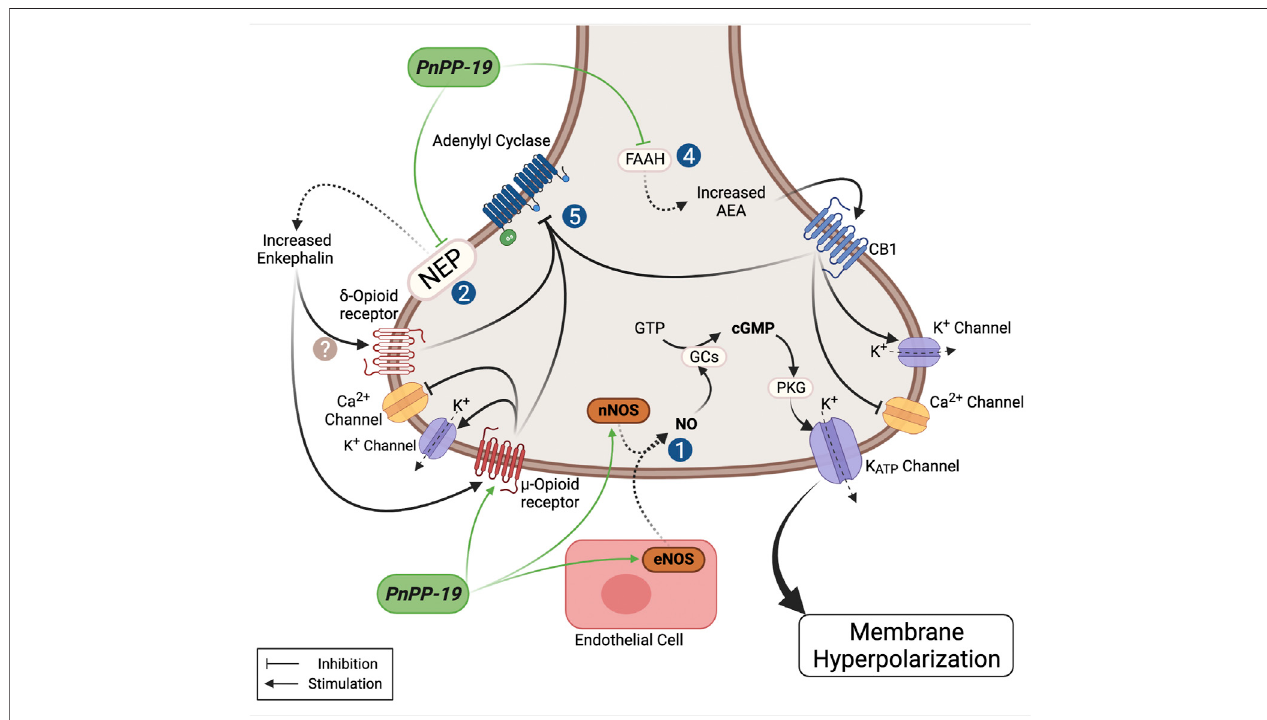
FIGURE3| SchematicmodelshowingthepossibleactionsofthePnPP-19peptide onantinociception. PnPP-19actsperipherallyandcentrally, via theopioidand cannabinoid systems, involving the µ- and δ -opioid receptors and cannabinoid 1 -receptor. It was proposed that the concomitant activation of the pathway of opioids and cannabinoids may also be facilitated by heterodimerization between receptors of these two ways. The activation of opioid and cannabinoid receptors causes the inhibition of adenylate cyclase activity. PnPP-19 appears to act directly on the µ-, but not on the δ -receptors, transfected into Xenopus oocytes. Activation of CB1 receptors is likely to be caused by increased levels of anandamide, as inhibition of anandamide degradation has been shown to potentiate the effect of the peptide. The peptide inhibited the enzyme neprilisin (NEP or enkephalinase - EC 3.4.24.11) in vitro , which degrades enkephalin, and was hydrolyzed by this enzyme after 24h of incubation. The peptide also stimulated eNOs increasing NO, which via PKG leads to opening of KATP, resulting in hyperpolarization. PnPP-19 inhibited the calcium current in dorsal ganglion root cells, which was reversed by noloxane, an opiate blocker, suggesting that this effect must be via the opioid receptor, which leads to calcium channel blockade and opening of potassium channels. The antinociceptive action of the peptide via the CNS using blockers also have shown its action on the opioid and cannabinoid system. This whole signaling cascade, on the action of PnPP-19, leads to a decrease of neuronal excitability and blocking the release of neurotransmitters, reducing pain. For more details see text. NEP, neprilysin enzyme (neutral endopeptidase); nNOS, neuronal nitric oxide synthase; eNOS, endothelial nitric oxide synthase; GCs, soluble guanylate cyclase; PKG, phosphoprotein kinase G; GTP, guanosine triphosphate; FAAH, fatty acid amide hydrolase; AEA, N-arachidonoylethanolamine or anandamide. Created with